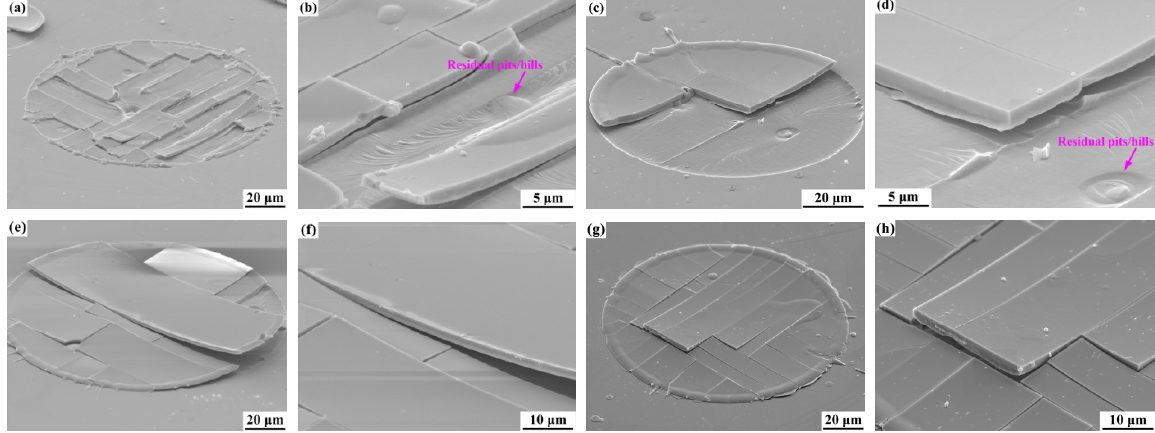
Fig. 4 Cross-sectional morphologies of 7YSZ splats at the deposition temperature of (a, b) 100, (c, d) 300, (e, f) 400, and (g, h) 600 ℃ . All crack patterns presented parabolic/tile-like shapes. Substrate spallation was widely observed. The dash pink arrow in (d) presented the residual